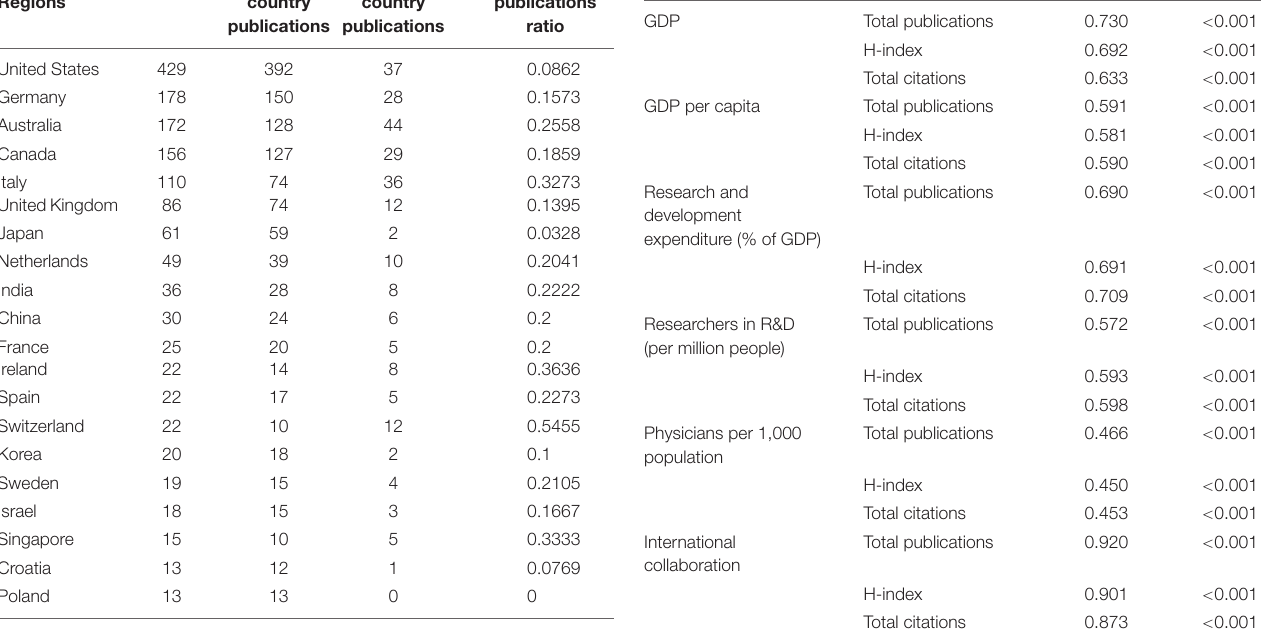
TABLE 7 | Top 20 leading countries/regions in psycho-oncology research between 1980 and 2021 based on the corresponding author’s country. Countries/ Articles Regions